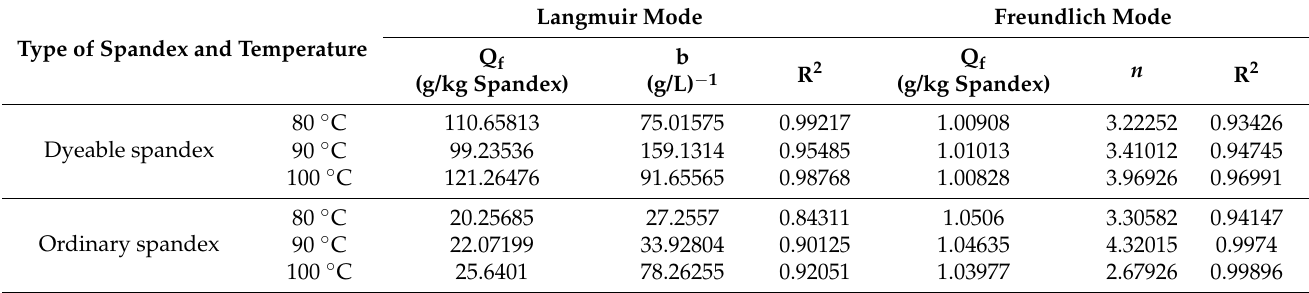
Figure 16. Freundlich model of the ordinary spandex dyed with neutral red G. Table 4. Adsorption isotherm model parameters of spandex dyed with neutral red